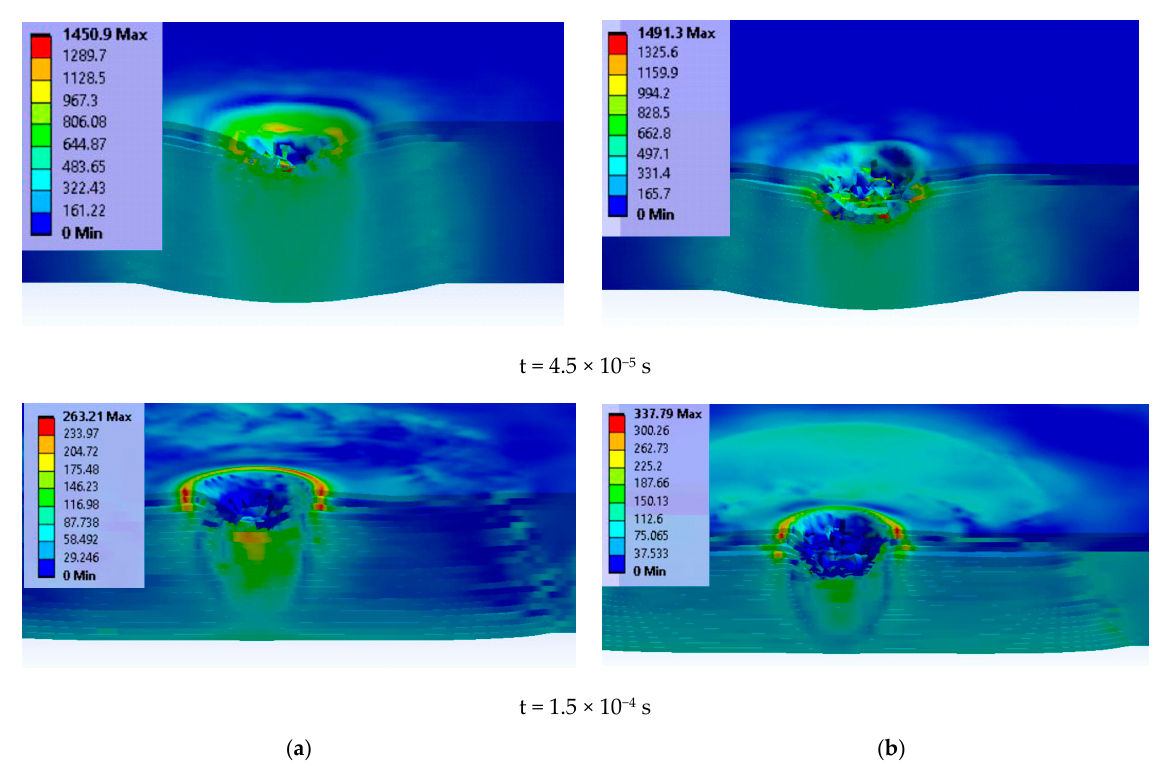
Figure 8. Cross section of the panel, at different time moments, for each modeled case (projectile is transparent) (color scale is given for each image, in MPa). ( a ) 9 mm FMJ. ( b ) 0.357 Magnum. Comparing the images of the panels at t = 4.5 × 10 − 5 s to those at t = 1.5 × 10 − 4 s (the simulation’s end), one may notice that even if there were no more breaks in the